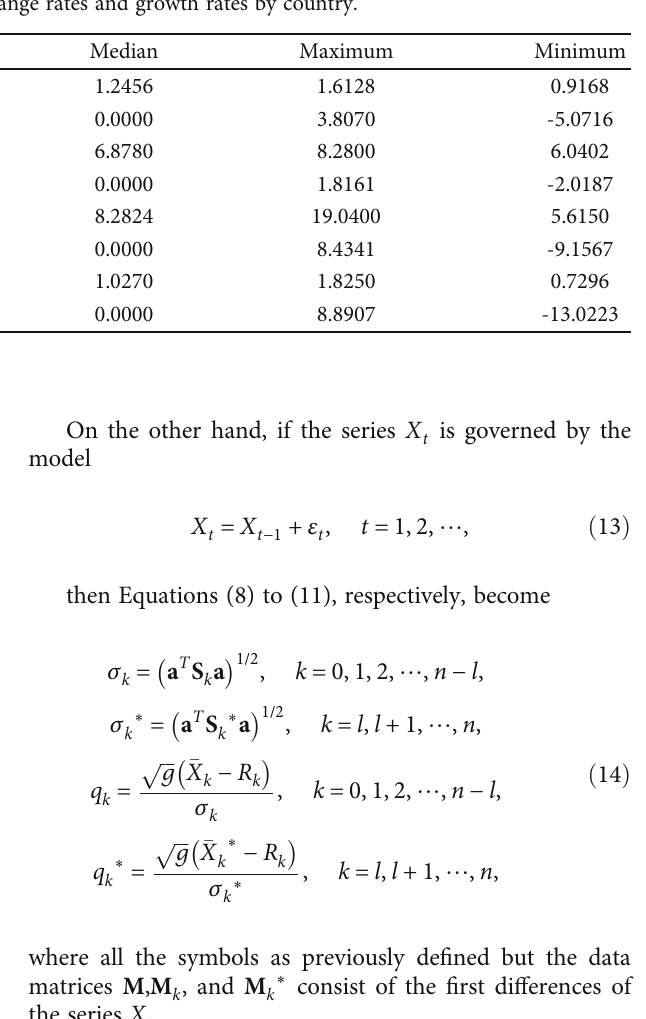
Table 3: Descriptive statistics of exchange rates and growth rates by